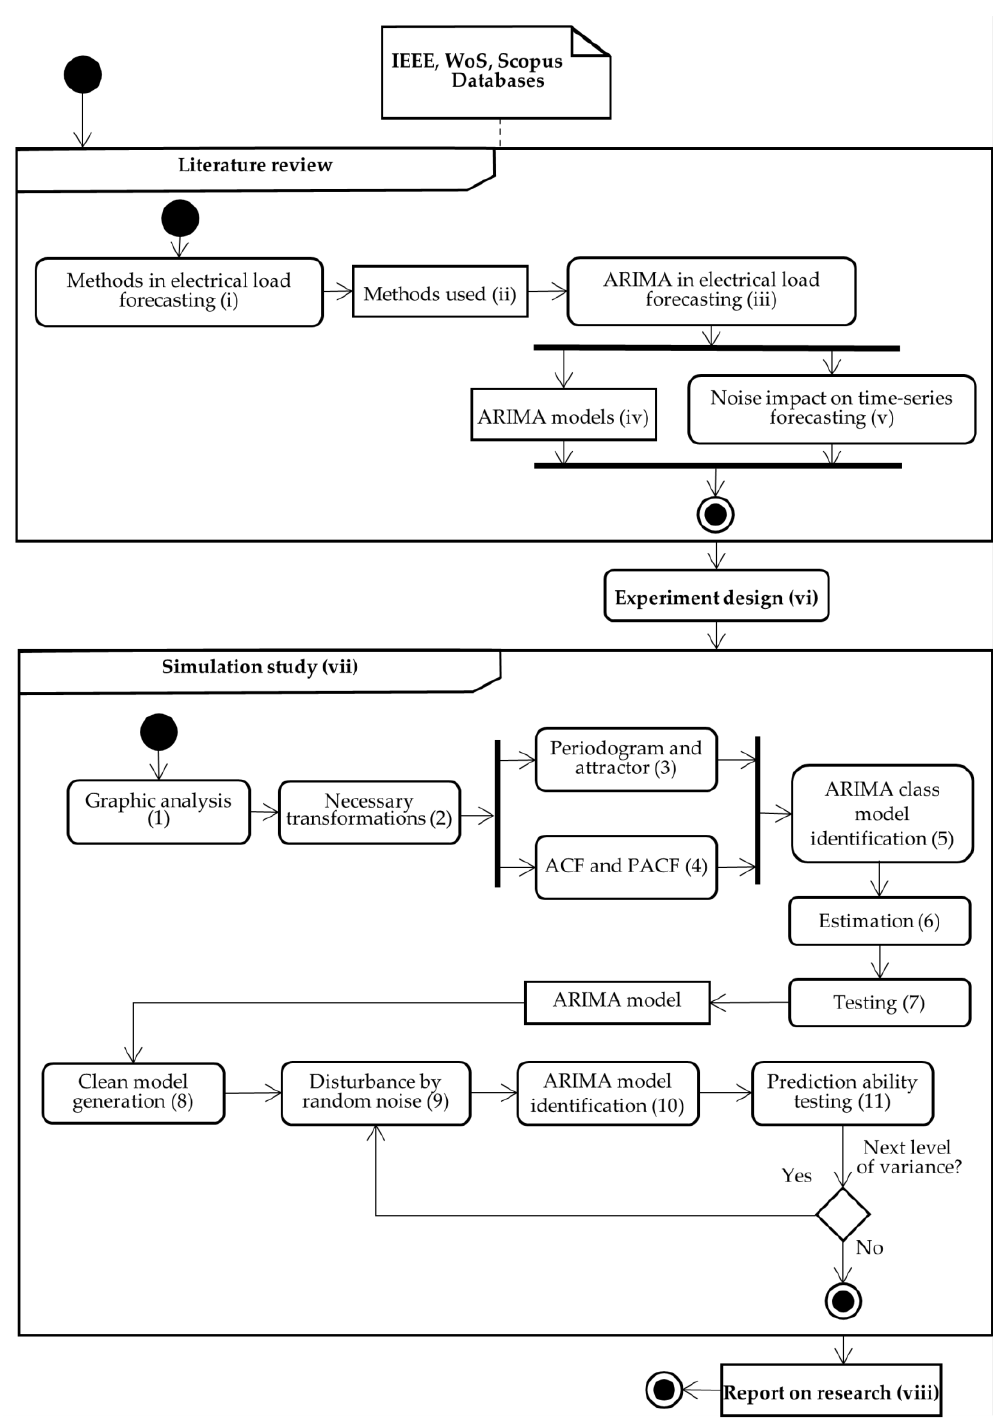
Figure 2. General research methodology.